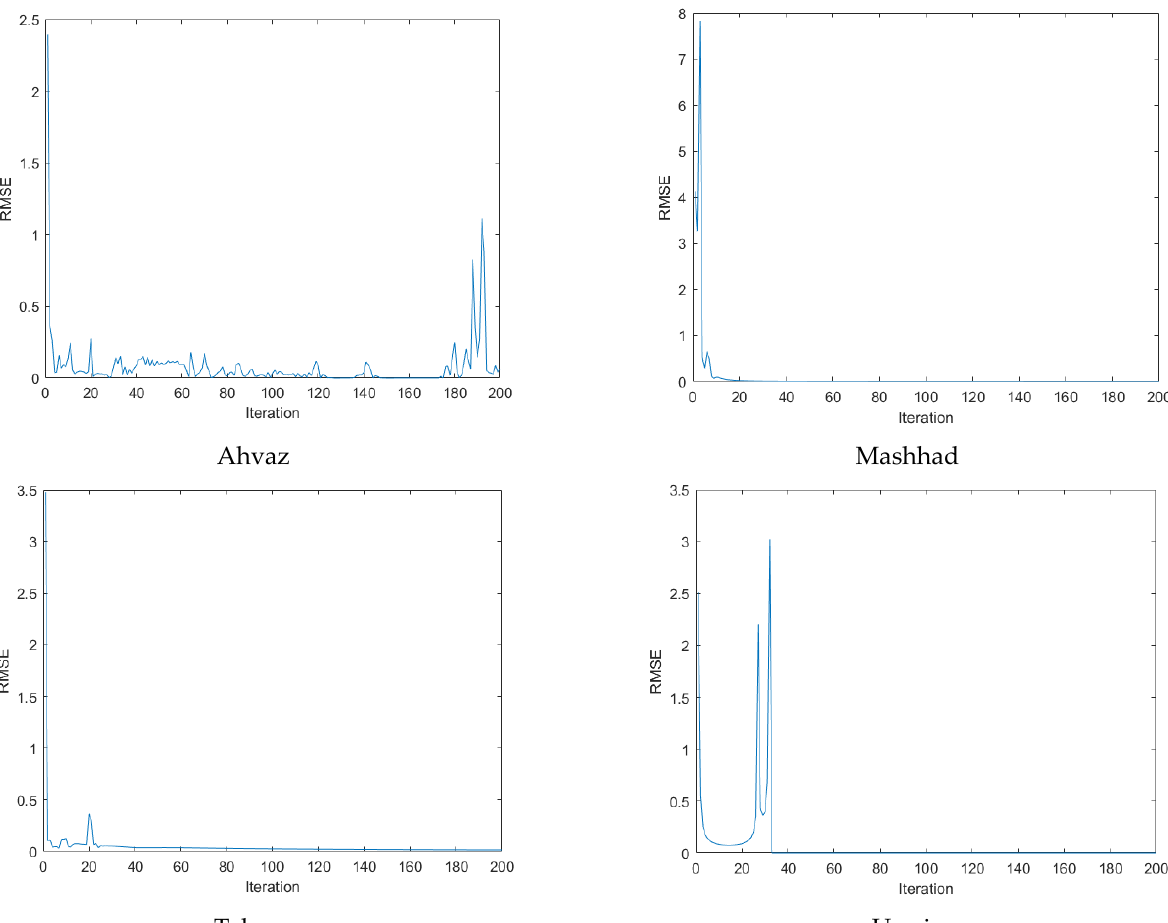
Figure 7. RMSE value for each city’s energy consumption process.